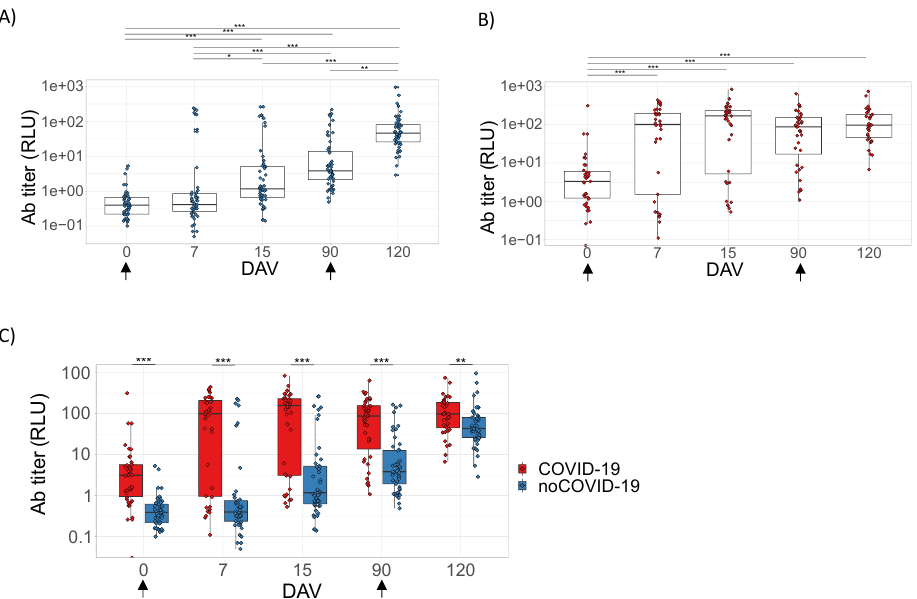
Figure 2. Total IgG anti-RBD (RBD region spike protein of SARS-CoV-2). Panels ( A – C ) refer to samples from volunteers immunized with the prime–boost protocol for ChAdOx1 nCoV-19 on days 0 and 90 (indicated by arrows). Individual serum samples were collected before vacci- nation (0 days = pre-immunization) to determine a baseline profile. In addition, volunteer